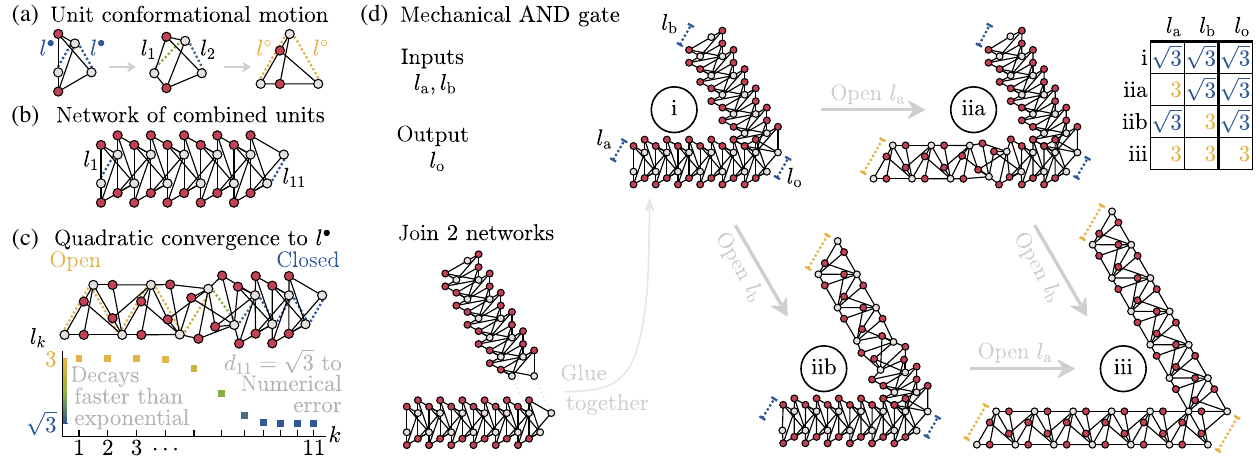
FIG. 11. Superstability and extreme localization through faster-than-exponential convergence. (a) Conformational motion of a unit from the superstable fixed point l (cid:129) to the unstable fixed point l ∘ . (b) Copies of this unit combine to form a network chain that (c) converges to l (cid:129) at a faster-than-exponential rate. (d) Two of these network chains, a and b , combine to form a mechanical AND gate, where the inputs l a and l b are the l 1 ends of each network. From i , the gate has two independently deformable conformational motions to form any linear combination of iia and iib . The signal can only continue to l o when both inputs are open at l a ¼ l b ¼ 3